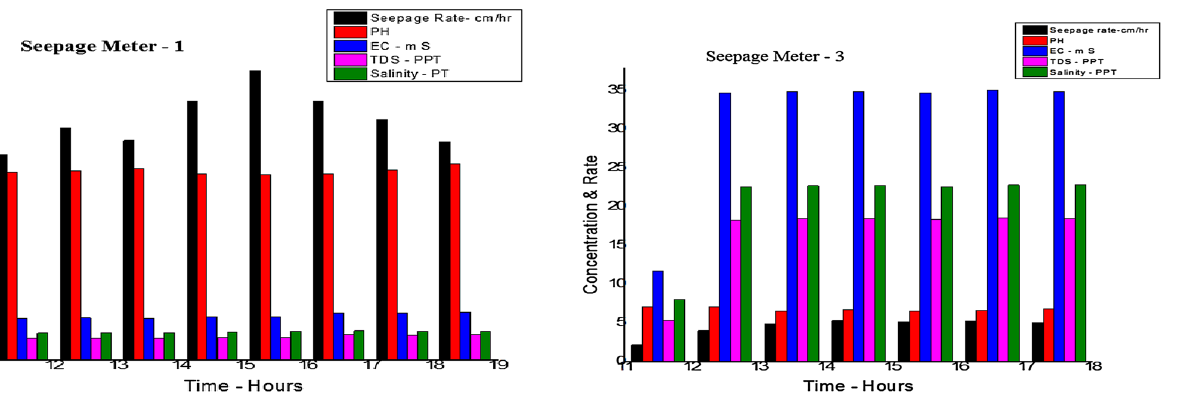
Fig. 7 Comparison of seepage rate and physicochemical parameters for the seepage meter